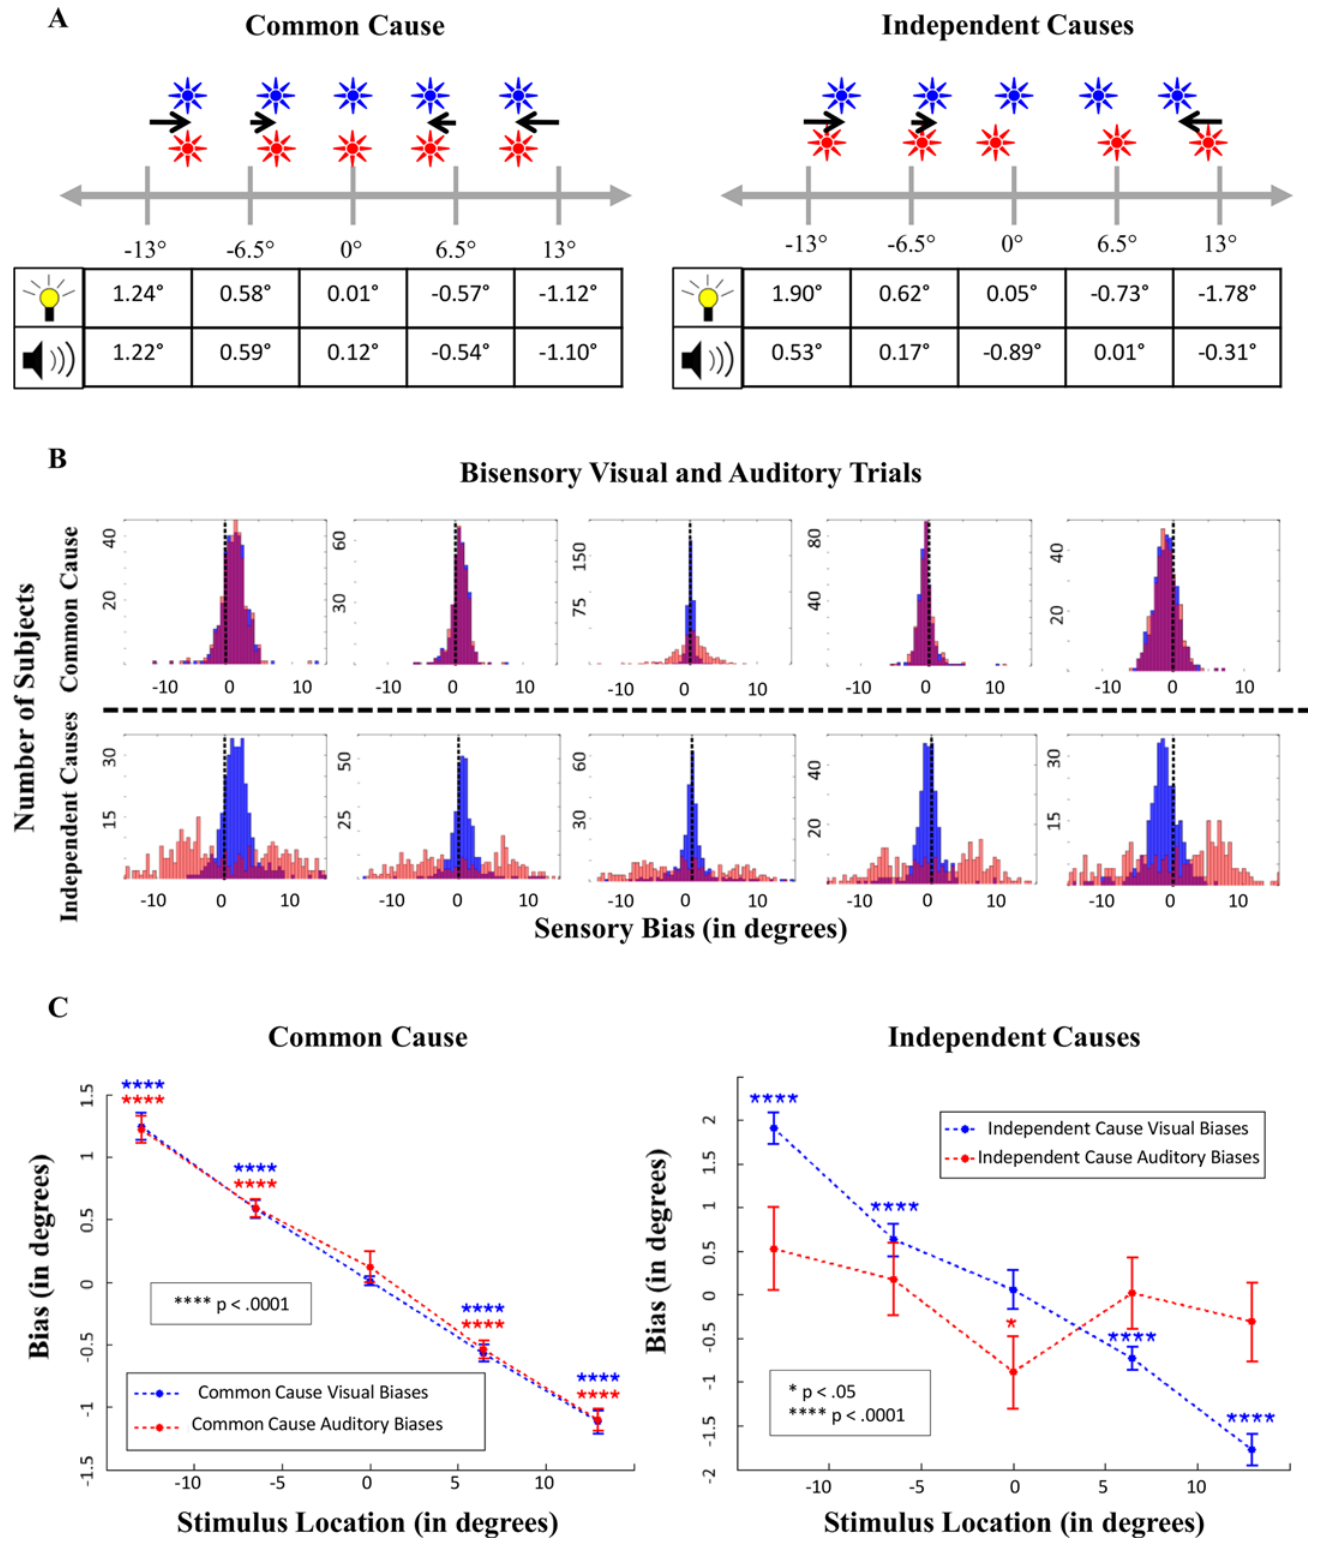
Fig 5. Bisensory trials, classified by inferring one common cause, or two independent causes. Panel A shows average biases and panel B displays the distribution of subjects ’ individual biases for each location. In Panel C, positive numbers indicate rightward biases, and negative numbers indicate leftward biases. SEM bars are shown around the mean bias in each modality for each